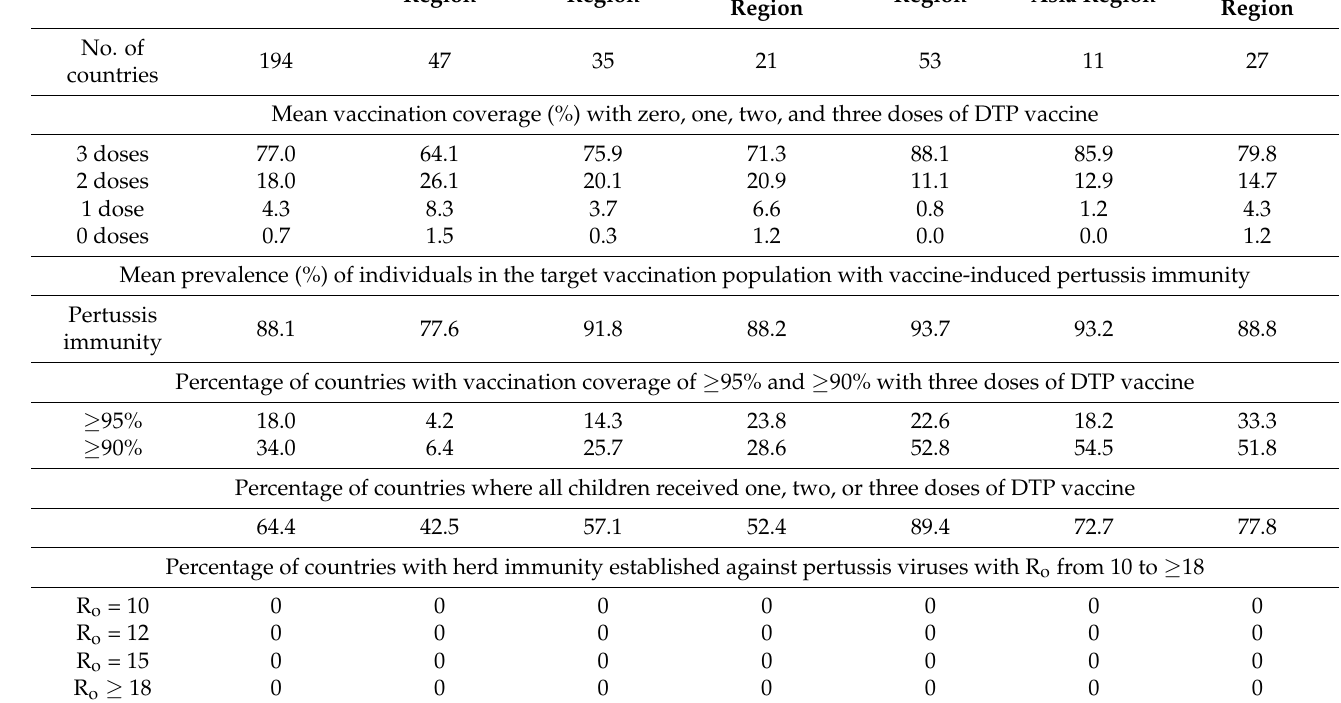
Table 5. Mean vaccination coverage with zero, one, two, and three doses of pertussis vaccine, mean prevalence of individuals in the target vaccination population with vaccine-induced pertussis protection, percentage of countries with anti-pertussis herd immunity established in the target vaccination population, and other pertussis vaccination indicators in regions of WHO in 2019. Western Eastern European South-East African American Pacific Mediterranean World Region Asia Region Region Region Region Region